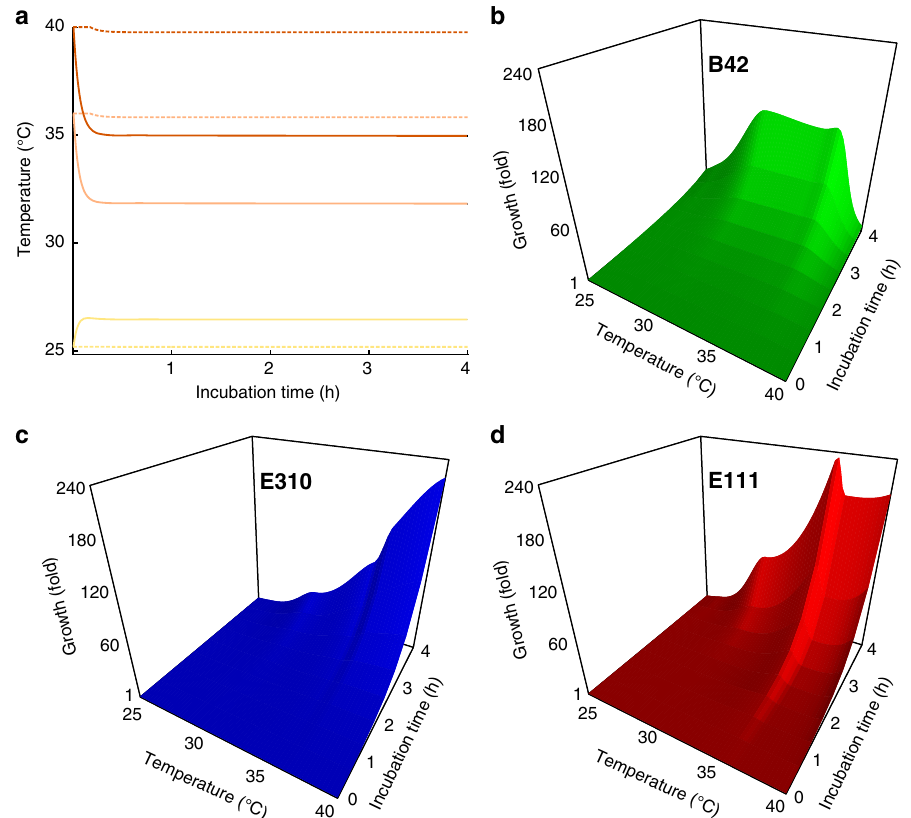
Fig. 4 The modeled changes in temperature and the growth of each strain over time. a The dashed and the solid curves represent the temperature changes at the lowest (0.057 μ l s − 1 ) and the highest (71.5 μ l s − 1 ) circulation speed, respectively. Temperature values for intermediate circulation speeds fall between these two lines. Yellow represents vessels at nominal incubation temperature of 25 °C, light orange vessels at 37 °C, and dark orange vessels at 42 °C. b – d Temperature is given on the x axis, time is given on the y axis, and growth is given on the z axis. In all panels, temperature corresponds to the actual temperature within the incubation vessels, not the